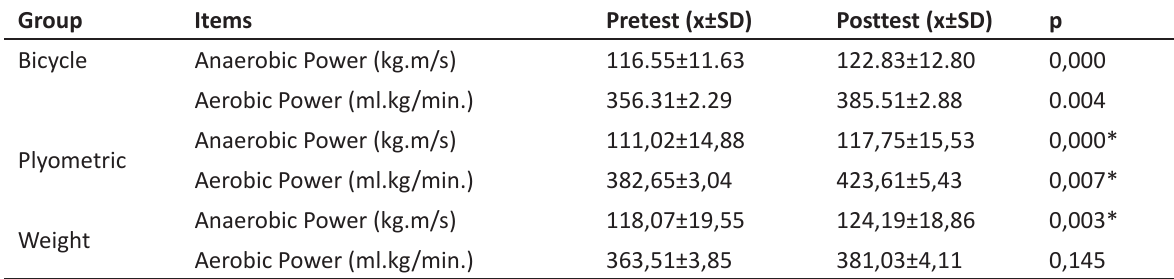
Table 2. The statistical analysis of the plyometric and weight groups aerobic-anaerobic power measurements pre and posttest values (n=10).